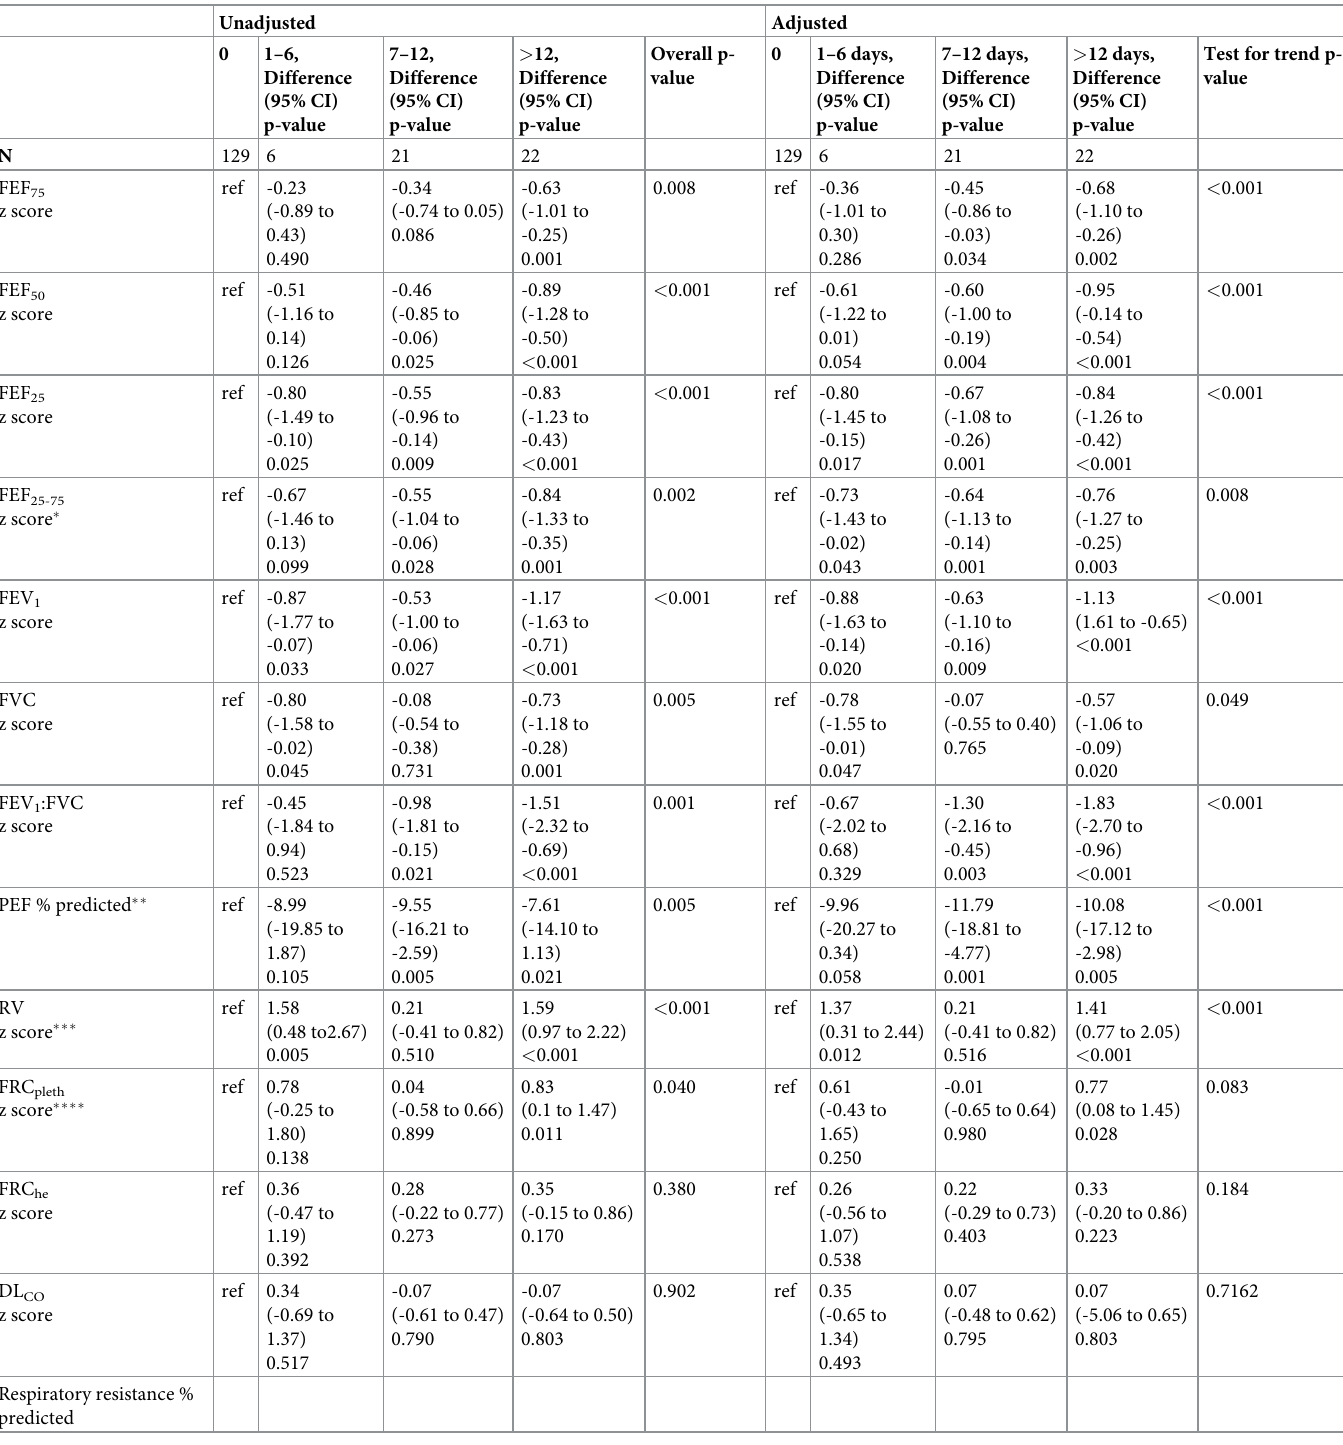
Table 5. Lung function and length of exposure to postnatal dexamethasone (days).